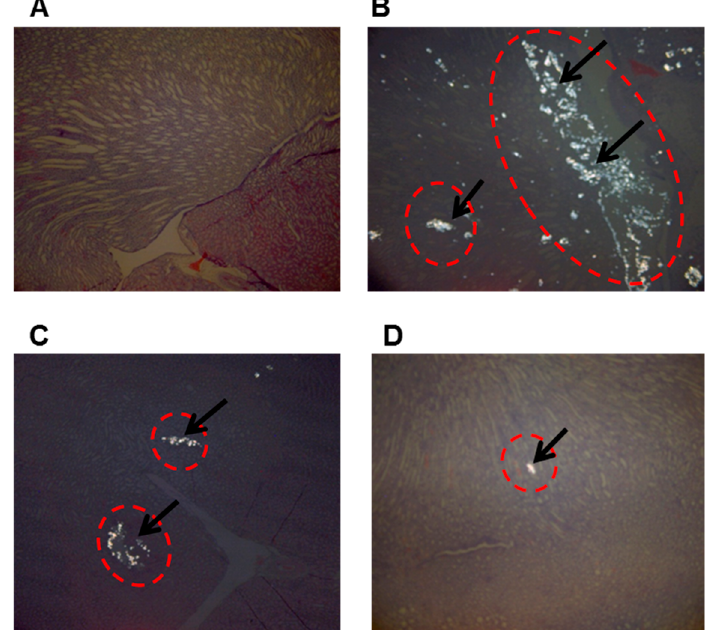
Figure 3. Representative microscopic images of stained of kidney sections from X-rats. The panels are as follows: blank (normal) ( A ); control (0.4% of ethylene glycol) ( B ); EG + low dose of drug ( C ); EG + high dose of drug ( D ). Arrows mean stones of kidney from X-rat. All panels are sections viewed by polarized light microscope (100×) after Hematoxylin and Eosin staining and under light microscope after Pizzolato’s staining (40×), respectively. Table 5. Stone values of X-rats kidney section treated ethylene glycol (EG) and drug treatment. Group No.